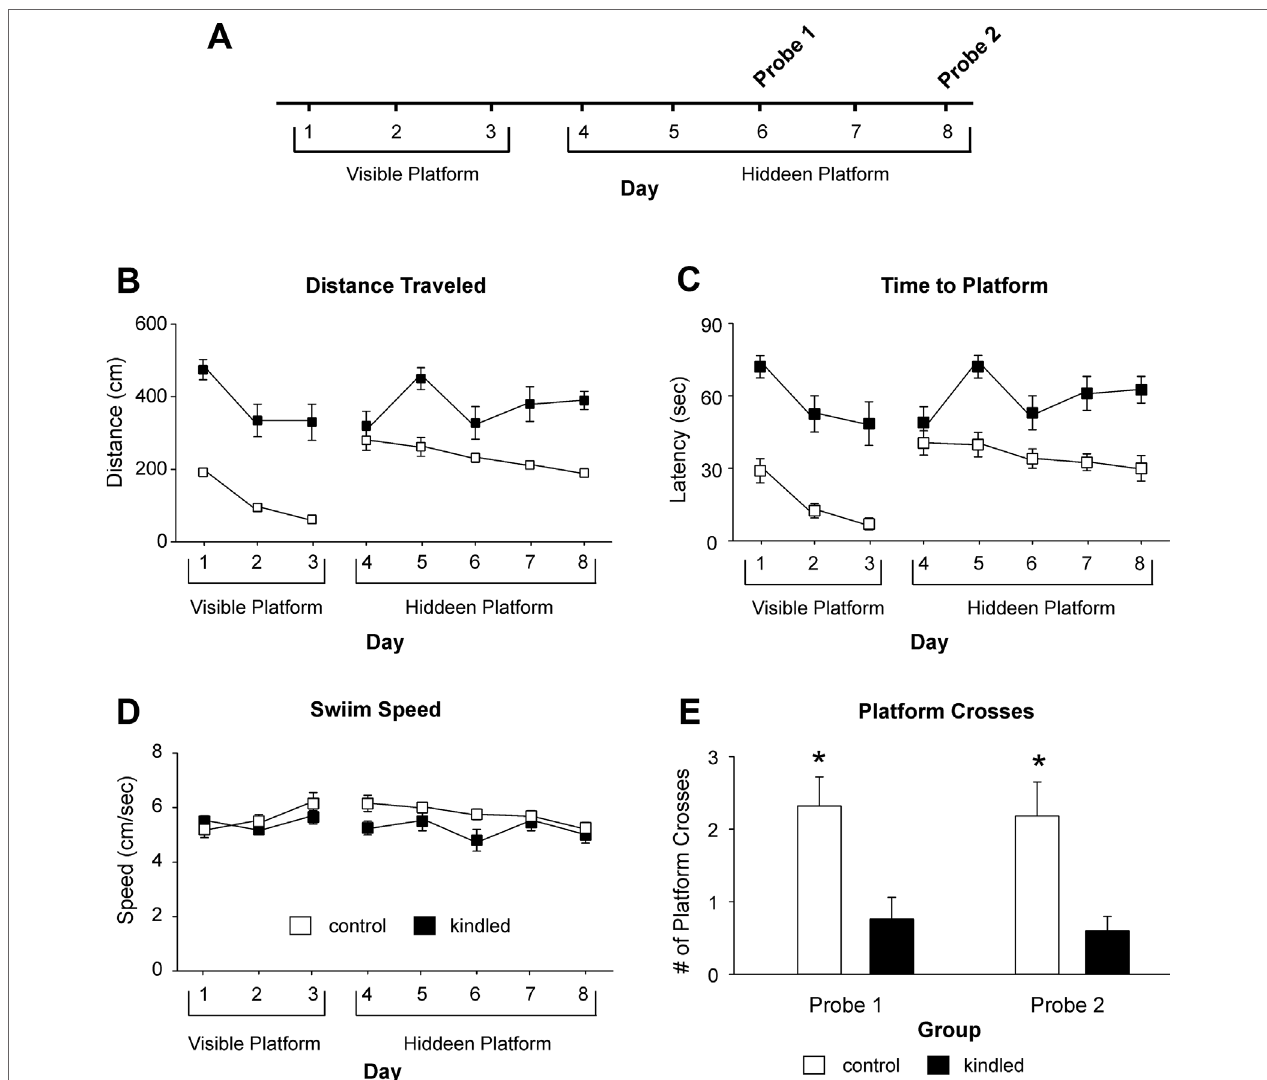
FIGURE 2 | Distances and latency Measures in the MWM test. (A) A schematic layout of the MWM protocol. The visible and hidden platform trials consisted of four trials per day and maximal 90 s per trial. The probe tests were one trial per day and 60 s per trial with the platform removed. Data in (B , E) (means ± SEM) were collected from 12 extended kindled mice and 12 handling control mice. (B , C) Distances and latencies needed to reach the platform. There were significant group differences in the distance and latency measures during the visible and hidden platform trials. (D) Swim speeds measured during the visible and hidden platform trials. There were no significant group differences in these measures. (E) Crosses of the platform location during the first and second probe test. The kindled mice crossed the platform location significantly less frequently (denoted by *) than the control